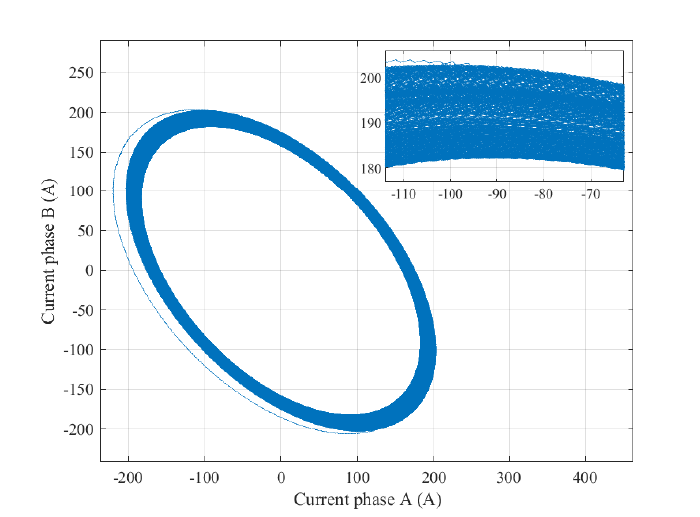
Figure 10. Phase portrait between DG1 currents phase A and B. Neimark–Sacker supercritical bifurcation forming a torus